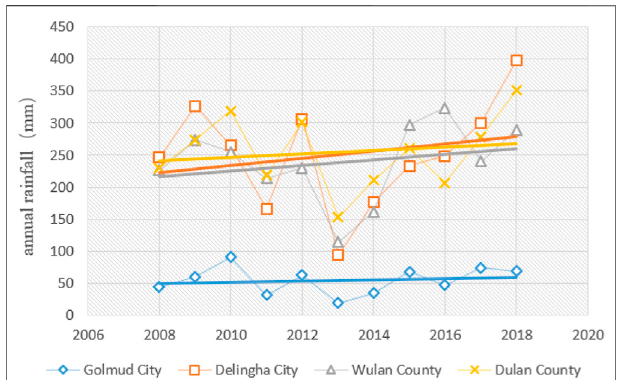
FIGURE 3 | Trend chart of annual average rainfall between 2008 and